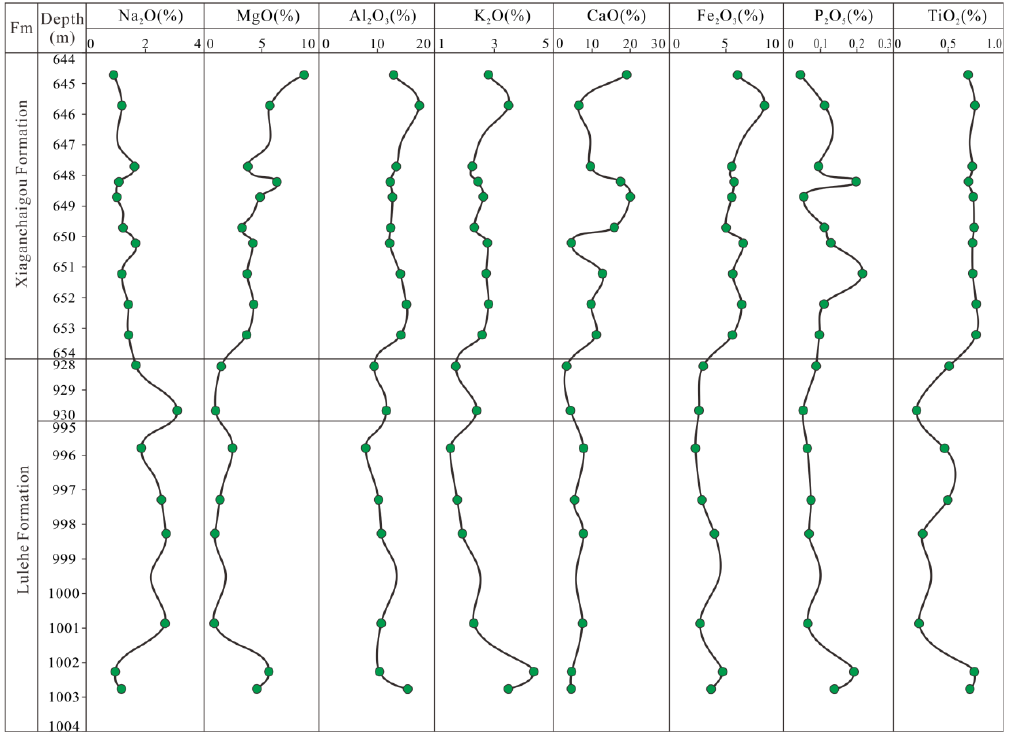
Figure 4. Variation curves of main oxide contents of the Eocene in the Pingtai area.